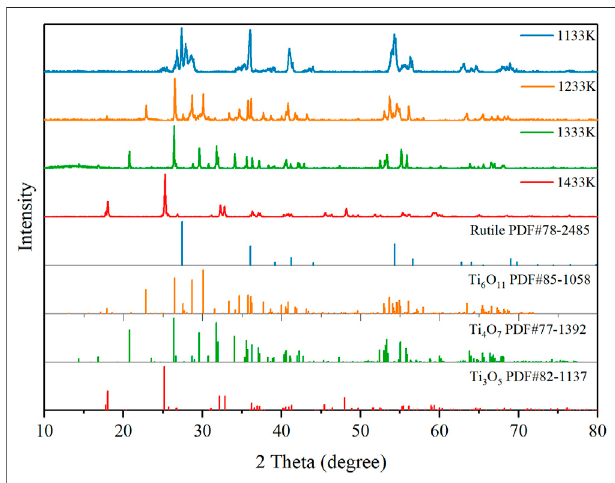
FIGURE 1 | XRD patterns of the REM sample prepared at various